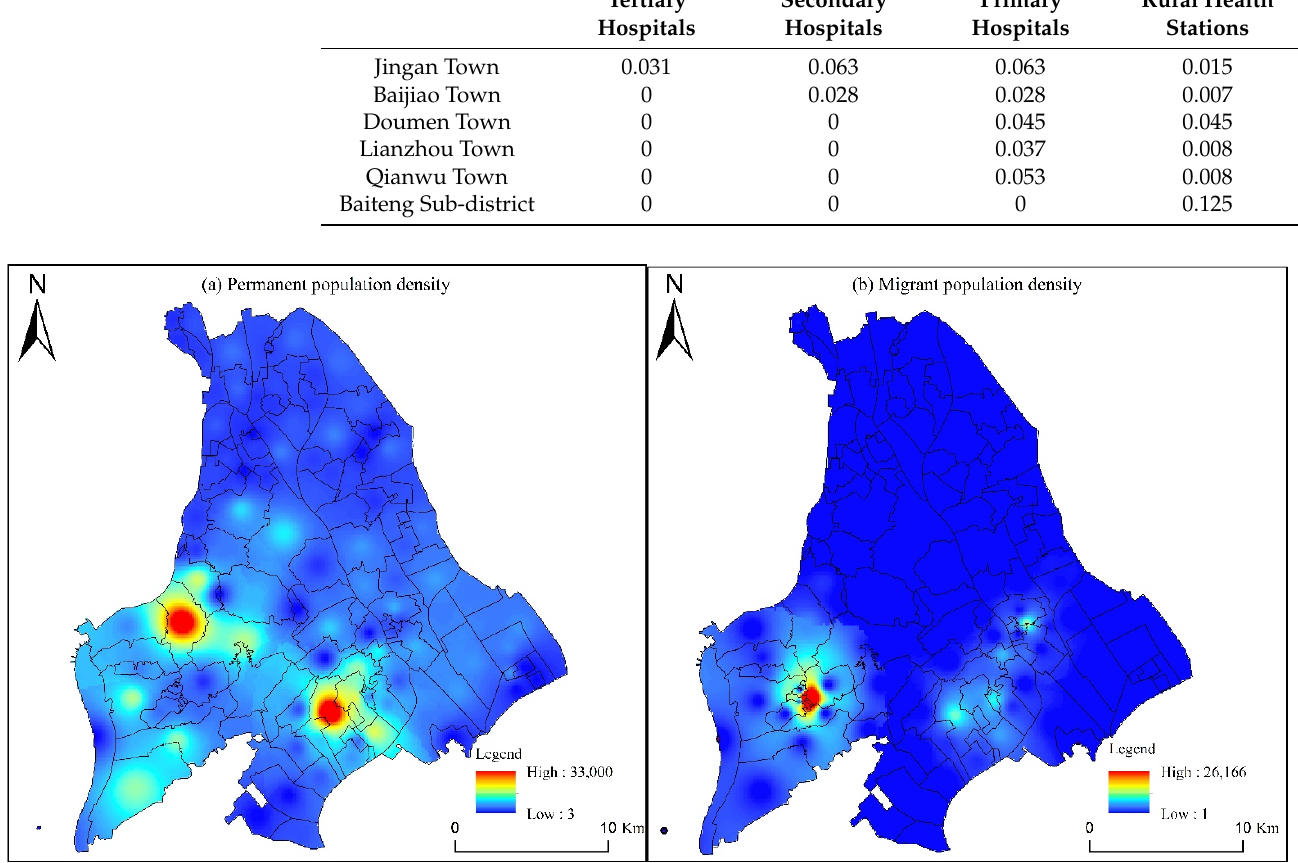
Figure 5. Spatial layout of permanent population density and migrant population density in Doumen District of Zhuhai (Guangdong Province), China, 2020. ( a ) Permanent population density. ( b ) Migrant population density.